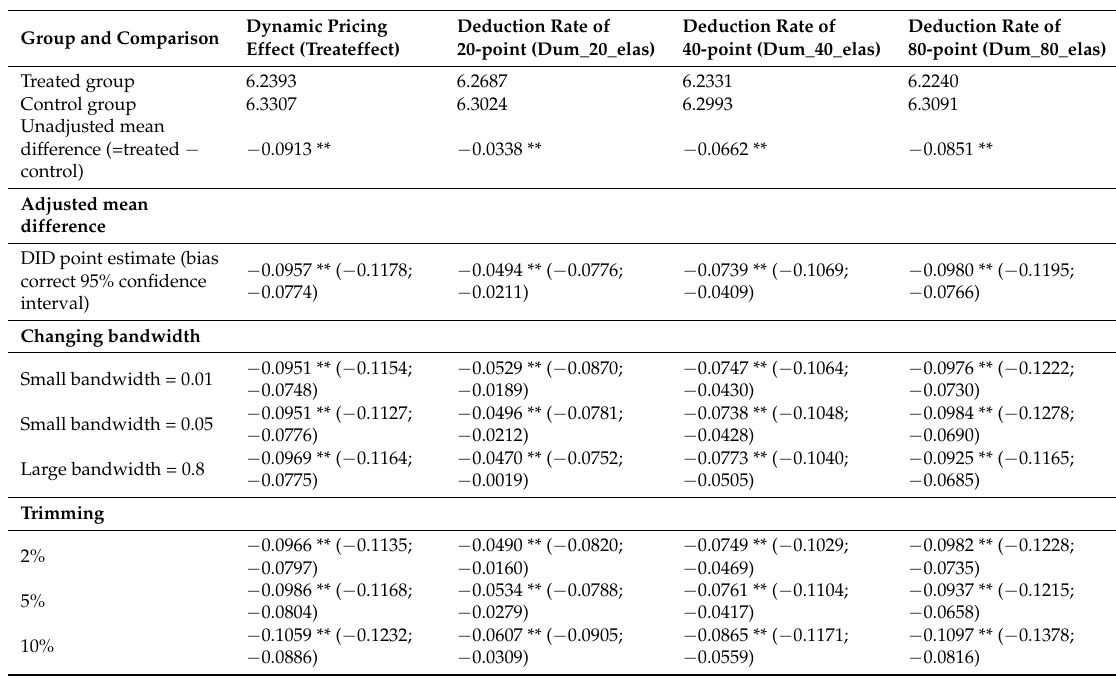
Table 9. Estimated average treatment effects for the treated electric power consumption: Propensity score analysis with local linear